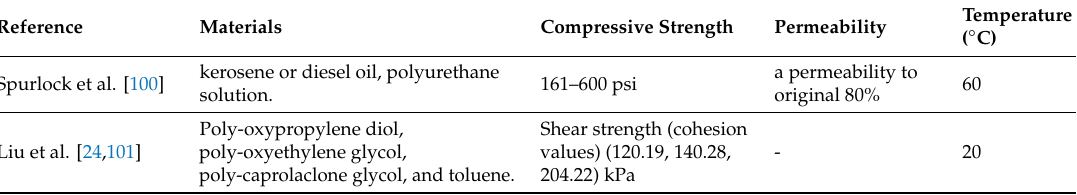
Table 19. Polyurethane resins methods to consolidate sand formation.